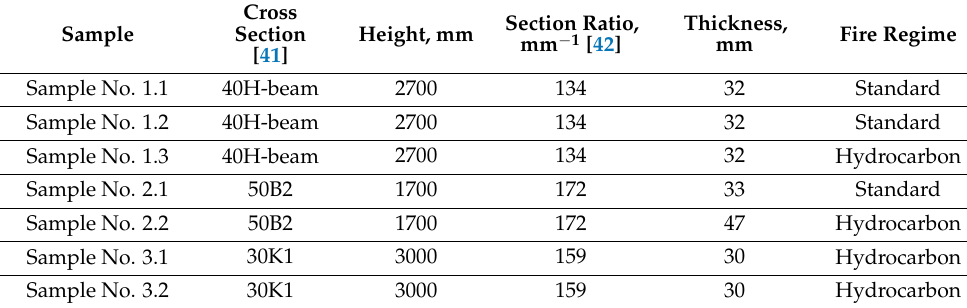
Table 1. The main parameters of samples with plaster